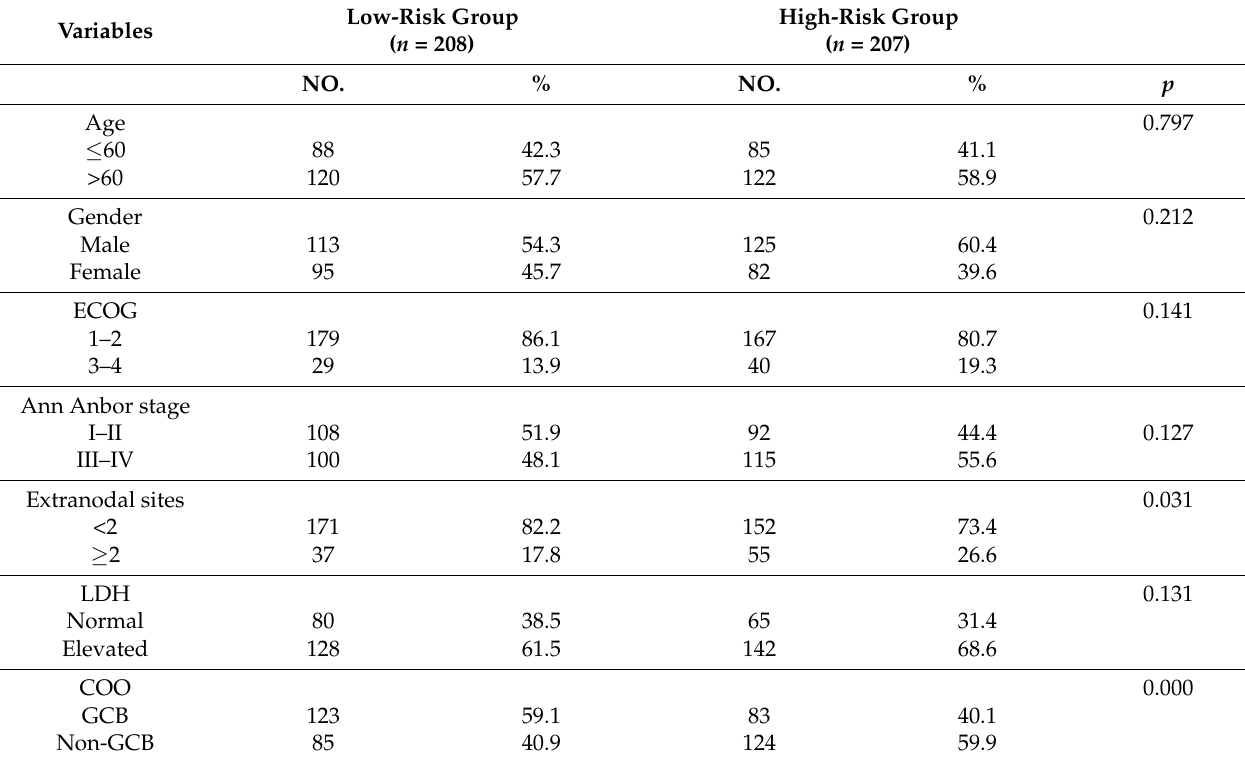
Table 2. The associations between ICD-related gene signature risk and patients’ clinical features in the training